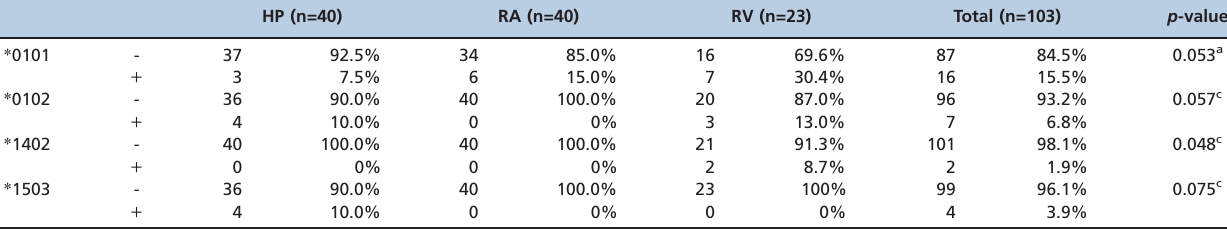
Table 3 - Distribution of HLA-DRB1 allelic frequencies among the patient groups.